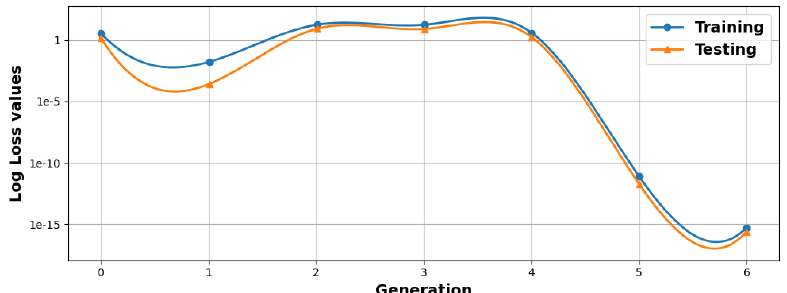
Figure 12: Learning curve showing the log loss values for different generations. The training and the testing curve values are obtained using the best trained model against the corresponding training and testing dataset in each generation respectively. The result is obtained for a randomly chosen class and the batch size is set to